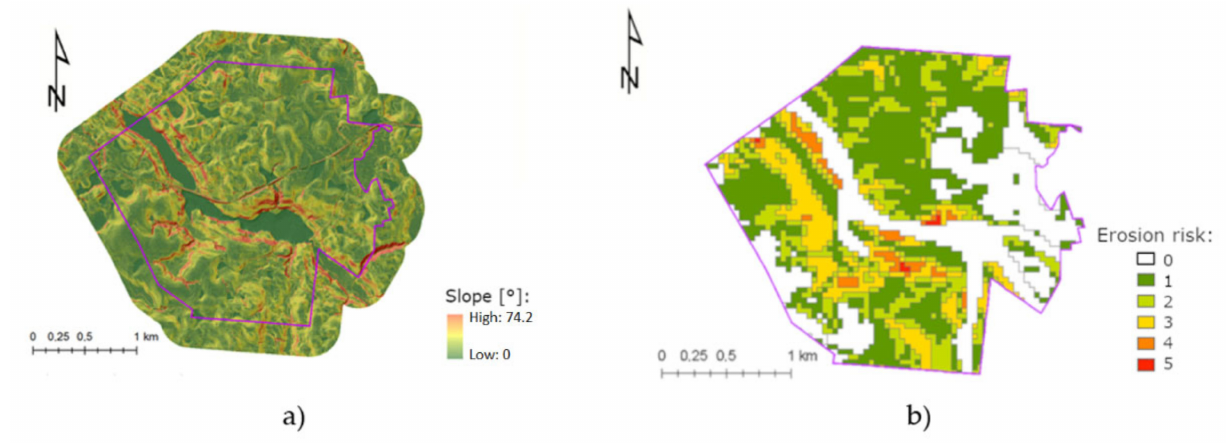
Figure 4. Bolcie research area: slope map with hill shade effects (data source: ALS DTM processing—1 m × 1 m spatial resolution) ( a ) and water erosion risk based on the IUNG expert classification from level 0—no risk to level 5—very high risk: 40 m × 40 m spatial resolution ( b ).